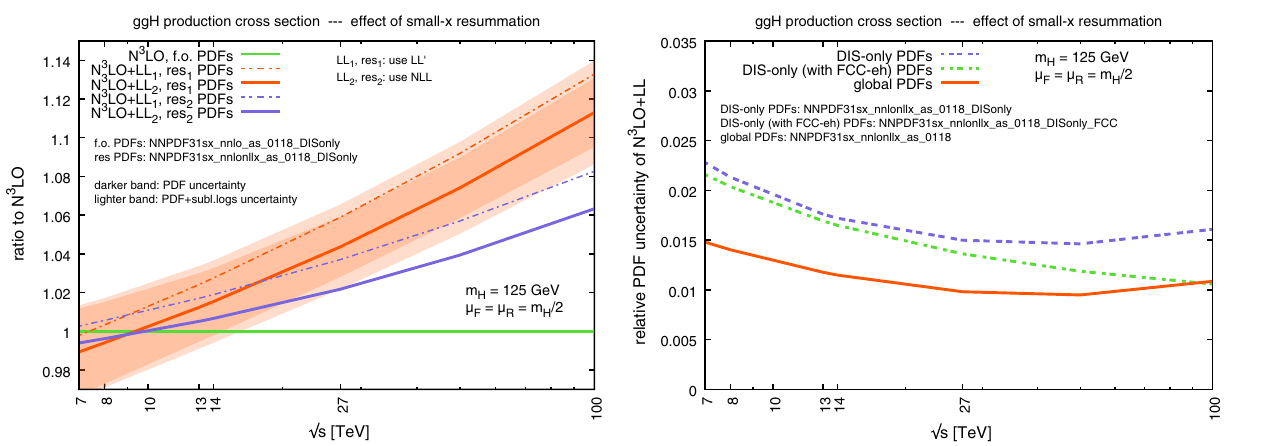
Fig. 7 Left plot: ratio of the N 3 LO + LL Higgs cross section to the N 3 LO one as a function of the collider energy, using various combina- tions for the implementation of resummation in the coefficient function and in the (DIS-only) PDFs. Right plot: relative PDF uncertainty as a